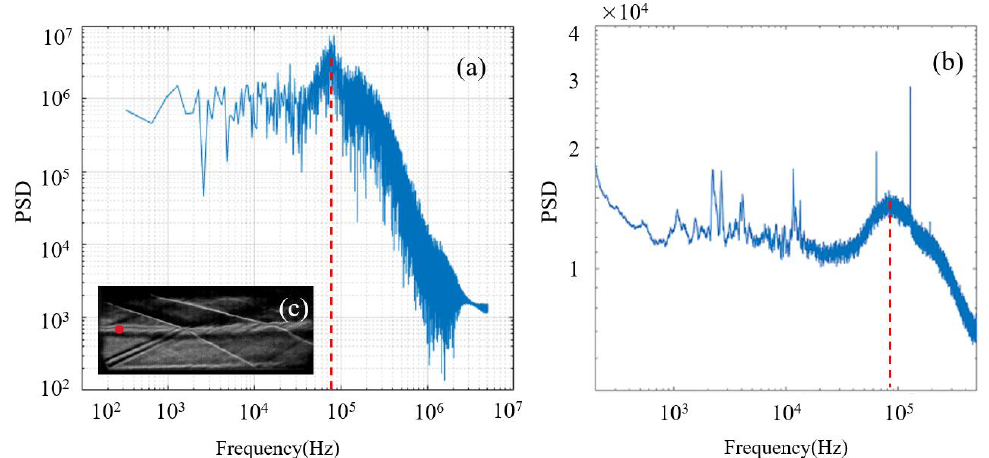
Figure 15. Power spectrum of the density at the measuring point. ( a ) Simulation, ( b ) FLDI, ( c ) the detection point.